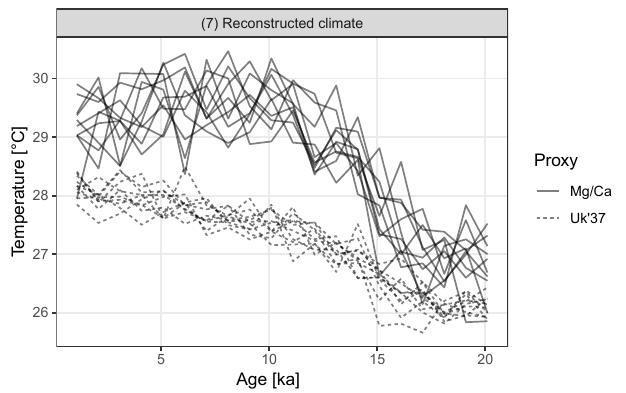
(cid:48) -based records. 37